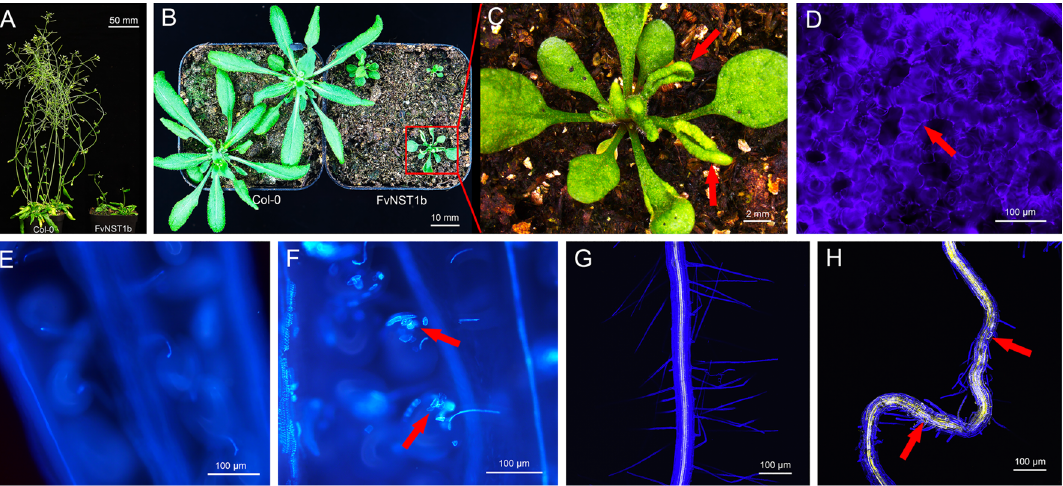
Figure 5. Overexpression of FvNST1b-GFP in Arabidopsis caused abnormal plant development and ectopic deposition of SCW. ( A ) WT and 35S:FvNST1b-GFP plants grow on soil for 40 days. 35S:FvNST1b-GFP plants grew more slowly than wild-type plants. ( B ) WT and 35S:FvNST1b-GFP plants grow on soil for 21 days. 35S:FvNST1b-GFP plants showing upwardly curled rosette leaves. ( C ) Magnified view of 35S:FvNST1b-GFP plant in ( B ). ( D ) Leaf epidermis of a 35S:FvNST1b-GFP plant under UV illumination. ( E ) Ovules of Wild-type plant under UV illumination. ( F ) Ovules of a 35S:FvNST1b-GFP plant under UV illumination. ( G ) Wild-type root stained with Calcofluor White and Auramine O. ( H ) A root from a 35S:FvNST1b-GFP plant stained with Calcofluor White and Auramine O. Root was abnormally bent and ectopic lignified secondary wall thickening is apparent as Auramine O fluorescence signal (yellow signal, red allows). Scale bars represent 50 mm for ( A ), 10 mm for ( B ), 2 mm for ( C ), and 100 μ m for ( D – H ).